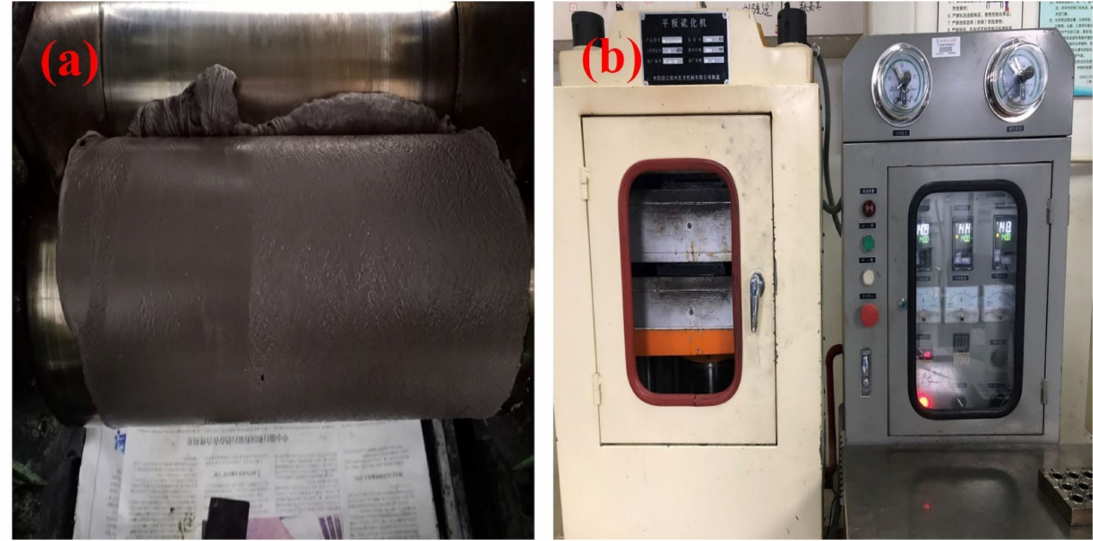
Figure 1. ( a ) the preparation process of various MPU/EUG composites by using an open mill; ( b ) the vulcanizing instrument used in this